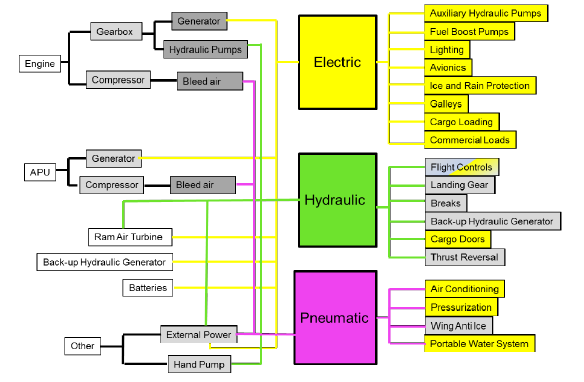
Figure 1: Demonstration of energy supply (left) and future electric systems for a more-electric